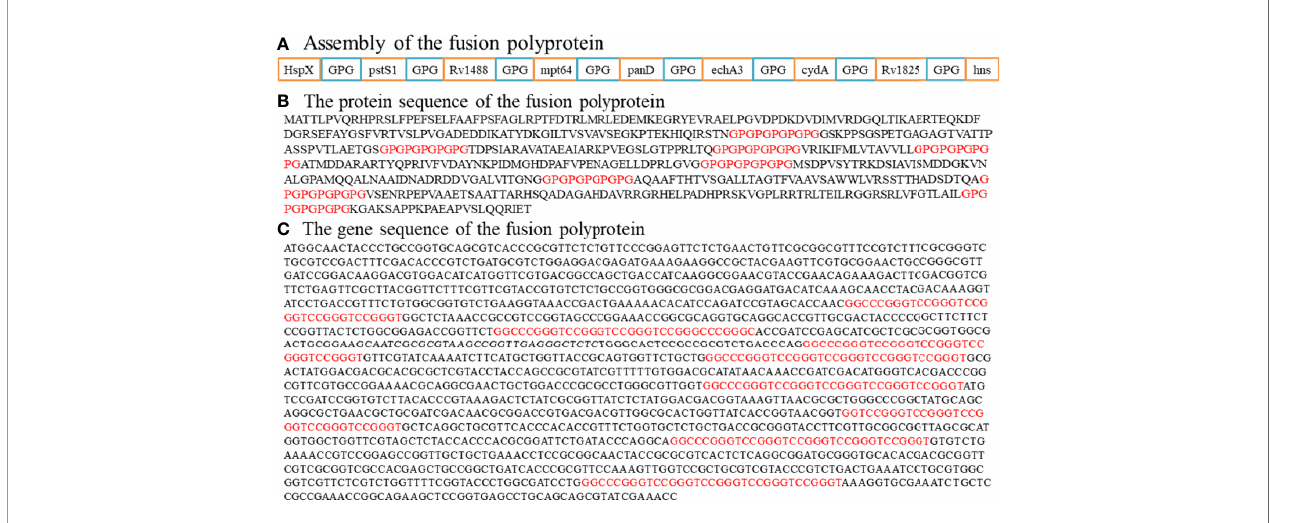
FIGURE 4 | Assembly of the fusion polyprotein. (A) HspX and other eight antigen segments were fused as an entirety by a sequence linker (GPGPGPGPGP). (B) The protein sequence of the fusion polyprotein. (C) The gene sequence of the fusion